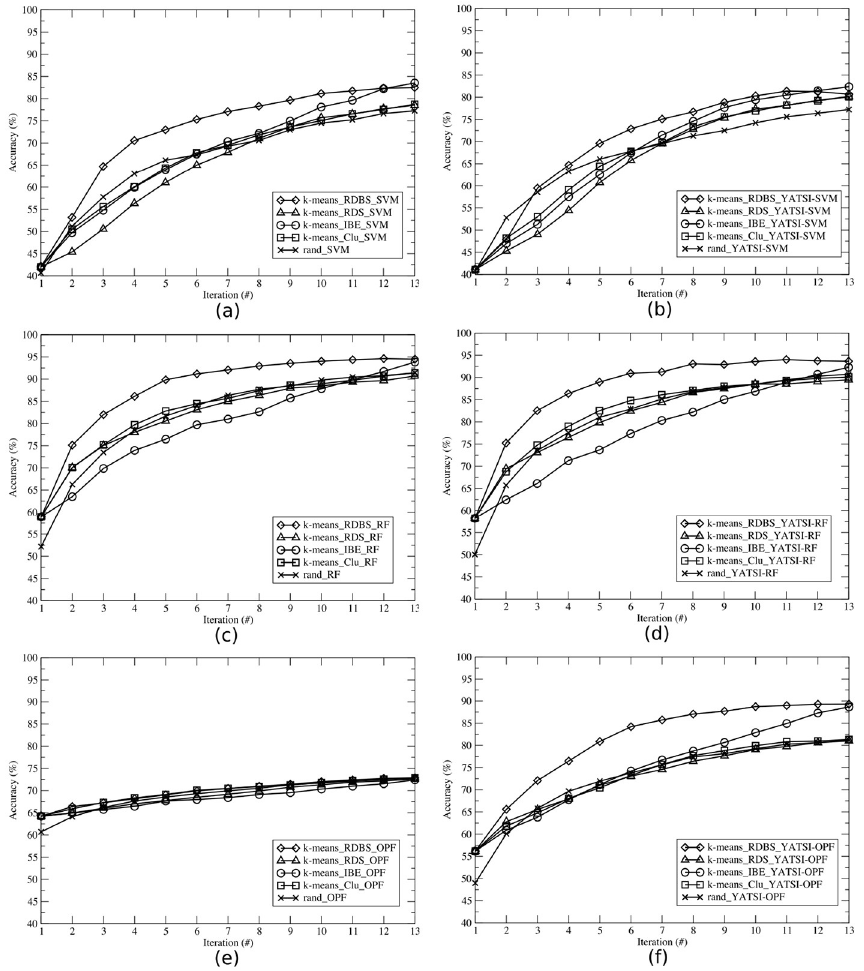
Fig 7. Average accuracies per iteration obtained by each selection strategy (RDBS, RDS, IBE, Clu, and rand), using the Pl@antLeaves II dataset and the classifiers: (a) SVM, (b) YATSI-SVM, (c) RF, (d) YATSI-RF, (e) OPF, and (f)